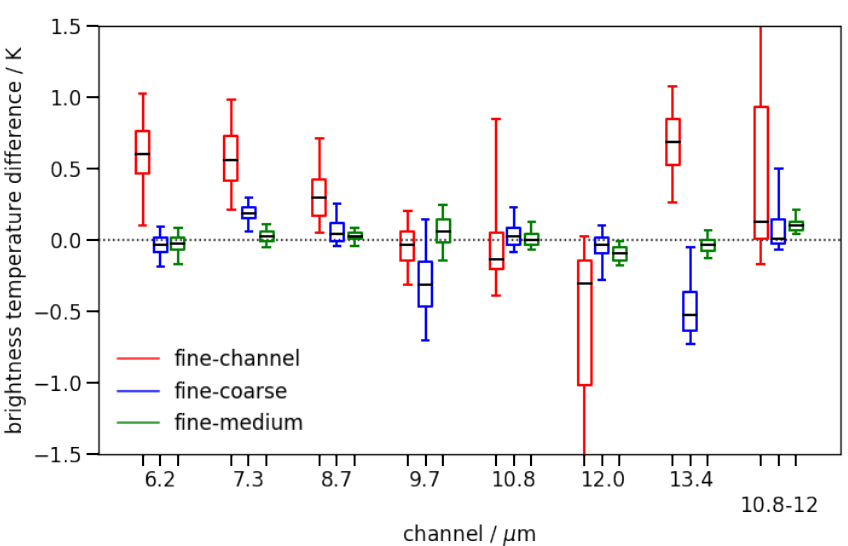
Figure 7. Brightness temperature differences for radiative transfer calculations of different REPTRAN parameterizations. The considered test dataset is described in the text. The boxplot shows the median, first and third quartile (box) and the 5th and 95th percentile